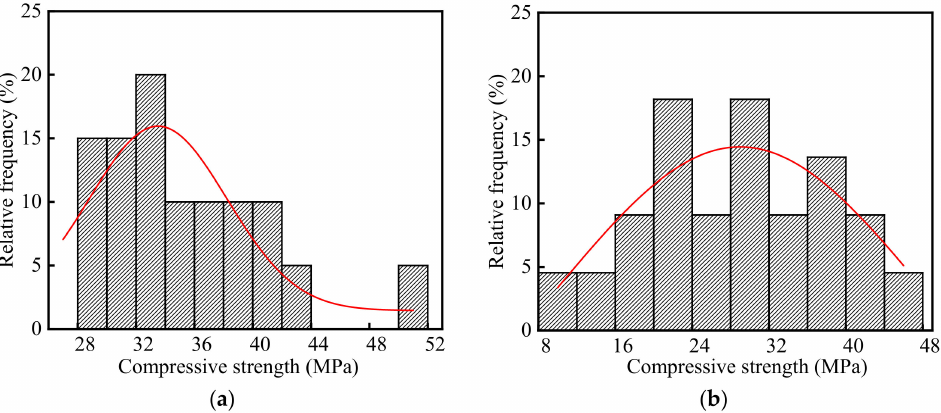
Figure 8. Frequency distribution histograms of concrete compressive strength in the steelworks: ( a ) Ingot casting bay; ( b ) Billet